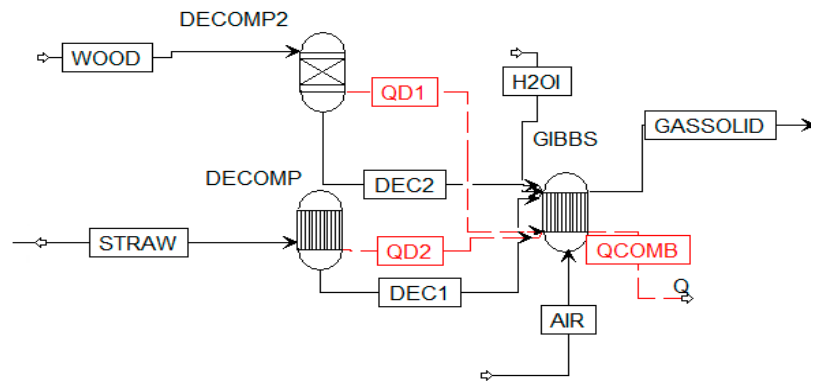
Figure 1. Flowsheet for the simulation of the co-incineration of rice straw and wood pellets.